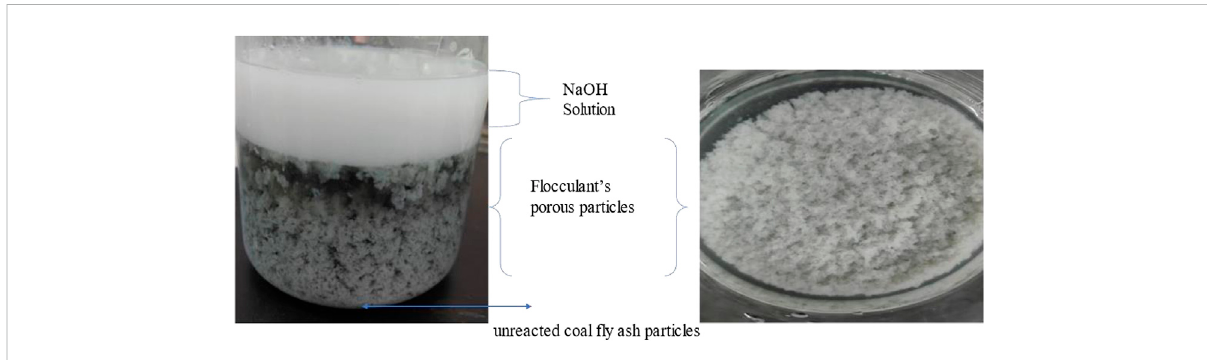
FIGURE 1 Flocculant ’ s porous particles of MCFA by the treatment of the multi-step base – acid – base (NaOH-HCl-NaOH)